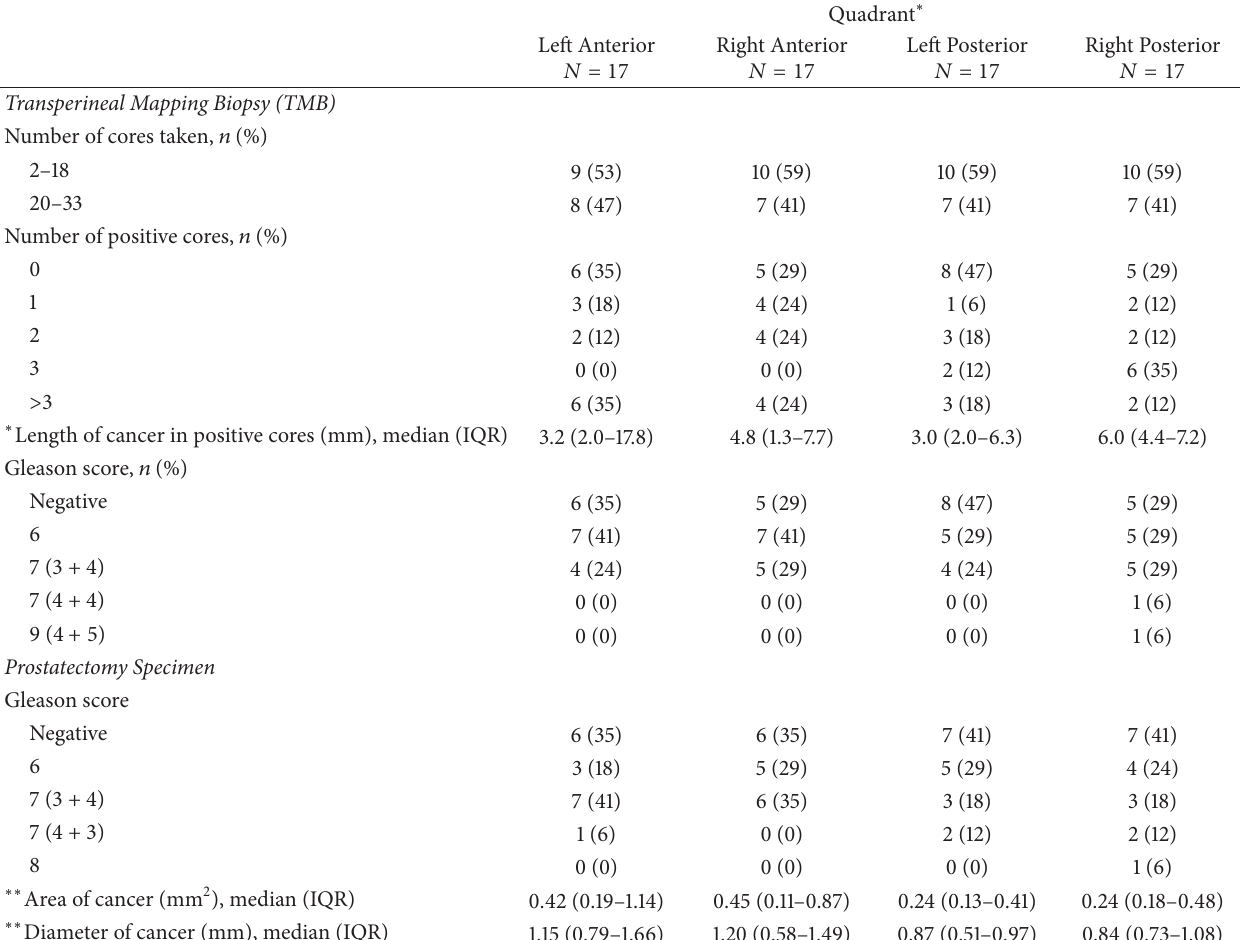
Table 3: Characteristics of TMB and prostatectomy specimen for the four prostate